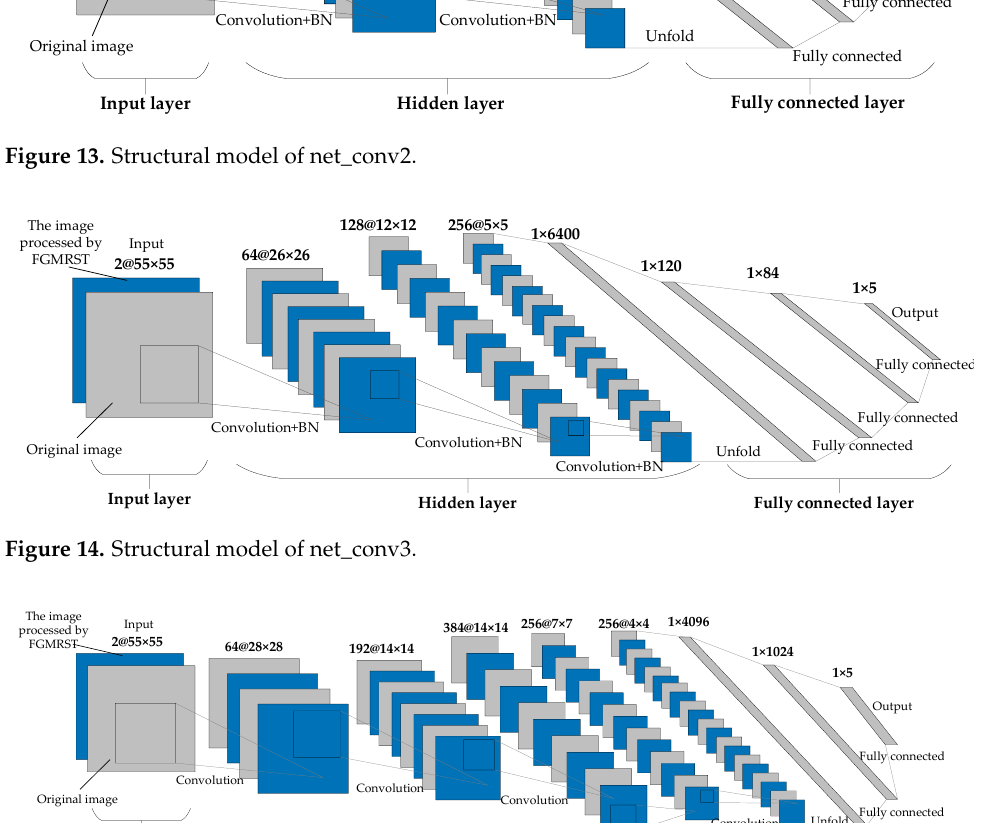
Figure 15. Structural model of net_alex. 4. Training network